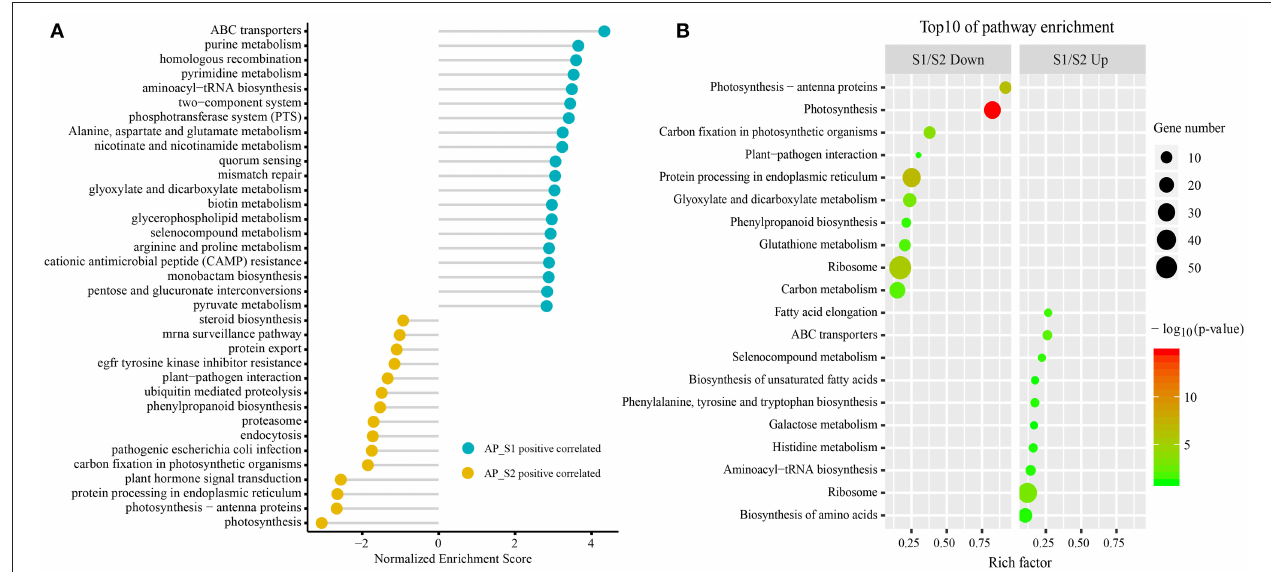
FIGURE 5 | The Kyoto Encyclopedia of Genes and Genomes (KEGG) pathway enrichment analysis between the two different harvesting periods of A. polytricha . (A) The KEGG pathway enrichment analysis by the GSEA of all the unigenes. (B) The top 10 KEGG enrichment pathways of the downregulated (left) and upregulated (right) unigenes,